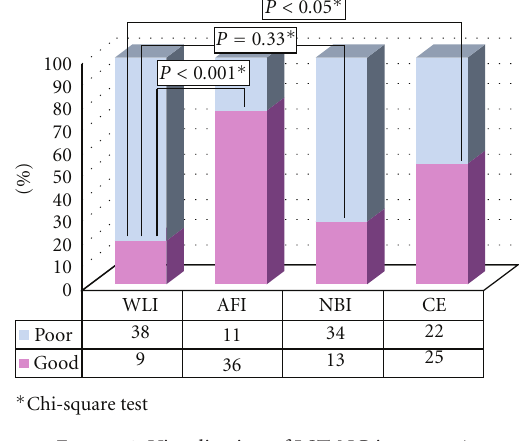
Figure 1: Visualization of LST-NG in group A.